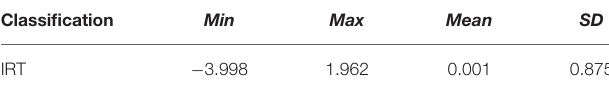
TABLE 3 | 2 × 2 confusion matrix table. TABLE 4 | The summary of θ parameters in IRT